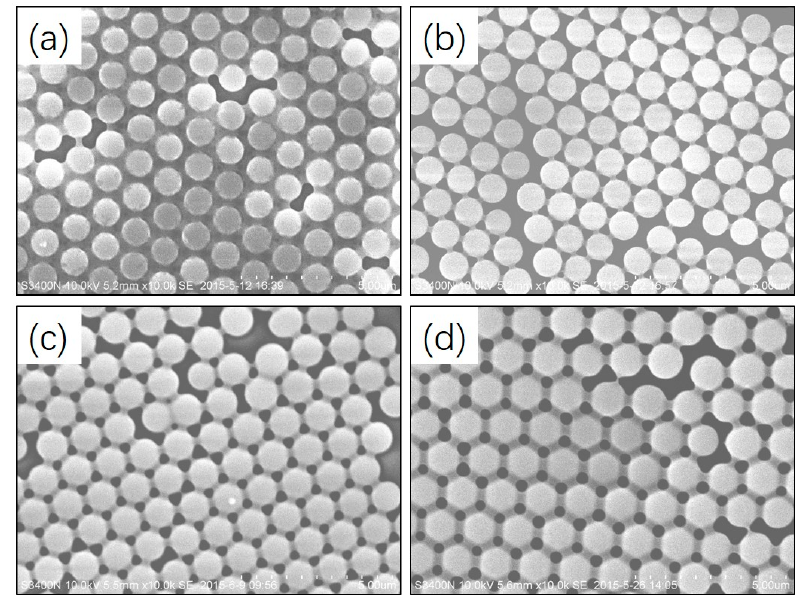
Figure 1. Scanning electron microscopy (SEM) images of polymeric microspheres prepared by photoinitiated reversible addition-fragmentation chain transfer (RAFT) dispersion polymerization of methyl methacrylate (MMA) with different concentrations of methyl methacrylic (MAA) added at the beginning of the reaction: ( a ) 0 wt %, ( b ) 2 wt %, ( c ) 6 wt %, ( d ) 10 wt %. Table 1. Synthesis and characterization data for polymeric microspheres prepared by photoinitiated RAFT dispersion polymerization of MMA with different concentrations of MAA added at the beginning of the reaction *.